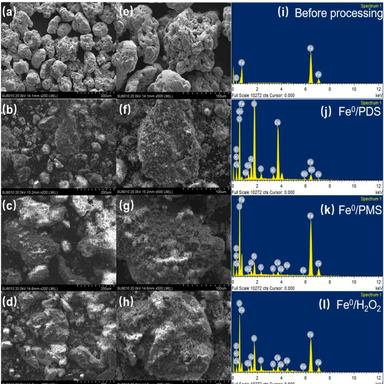
SEM images (a–h) and EDS patterns (i–l) before and after the degradation of petroleum hydrocarbons in OBDC by the Fe0 /PMS, Fe0 /PDS, and Fe0 / H2O2 systems.